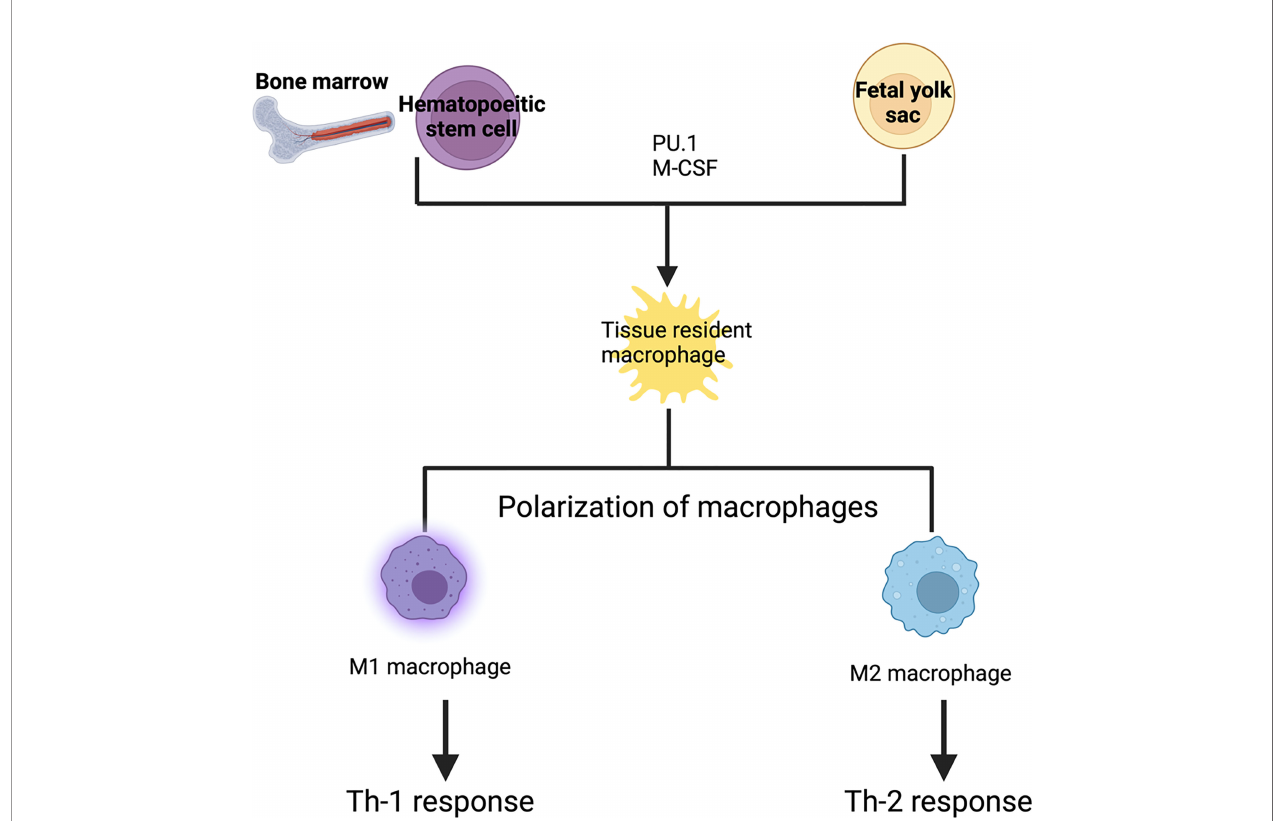
FIGURE 1 | Development of tissue resident macrophages: Tissue resident macrophages are derived from either blood monocytes or fetal yolk sac. Depending upon the signals they receive, they form tissue speci fi c macrophages. PU.1 and macrophage colony stimulating factor are required for the differentiation into tissue resident macrophages. These tissue resident macrophages can be polarized into either M1 or M2 macrophages. M1 macrophages are activated macrophages which result in a Th-1 response (killing intracellular pathogen) whereas M2 macrophage are alternatively activated macrophages which result in a Th-2 response (wound healing, and tissue